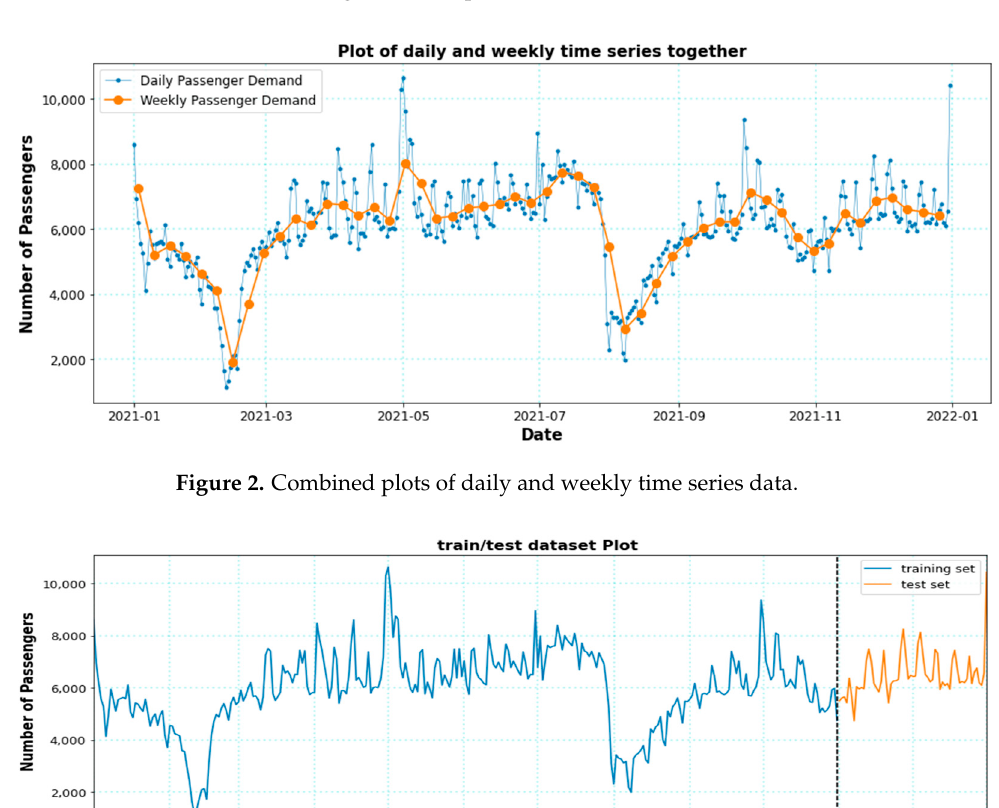
Figure 2. Combined plots of daily and weekly time series data.